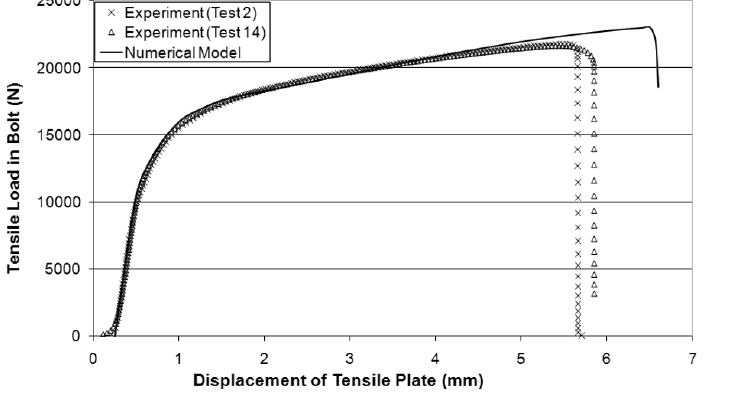
Fig. 8. Comparison with experimental load-displacement data, static tension